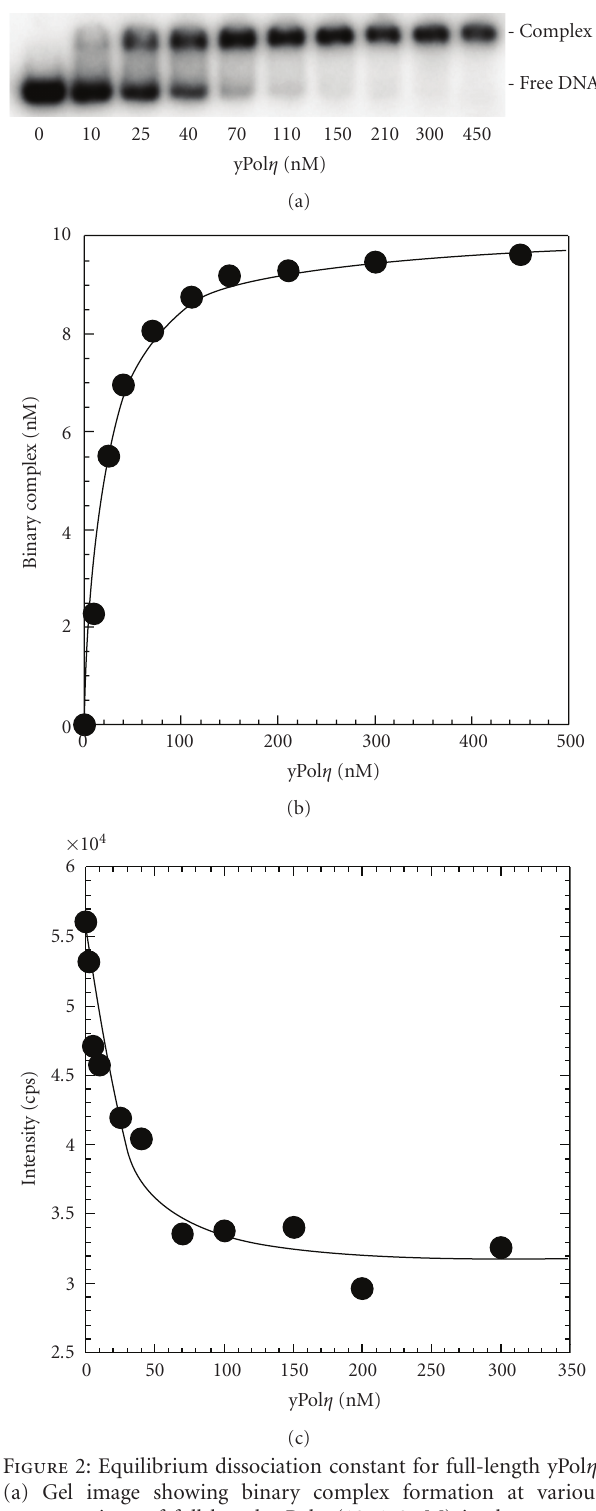
Figure 2: Equilibrium dissociation constant for full-length yPol η . (a) Gel image showing binary complex formation at various concentrations of full-length yPol η (10–450 nM) in the presence of 5 (cid:2) -[ 32 P]-labeled D-1 DNA (10nM). (b) The concentration of the binary complex was plotted as a function of full-length yPol η = 16 ± 1nM. (c) For the concentration and fit to (2) to yield a K DNA d fluorescence titration assay, a plot of fluorescence intensity versus full-length yPol η concentration was fit to (3) which resolved a K DNA d = 7 ± 4